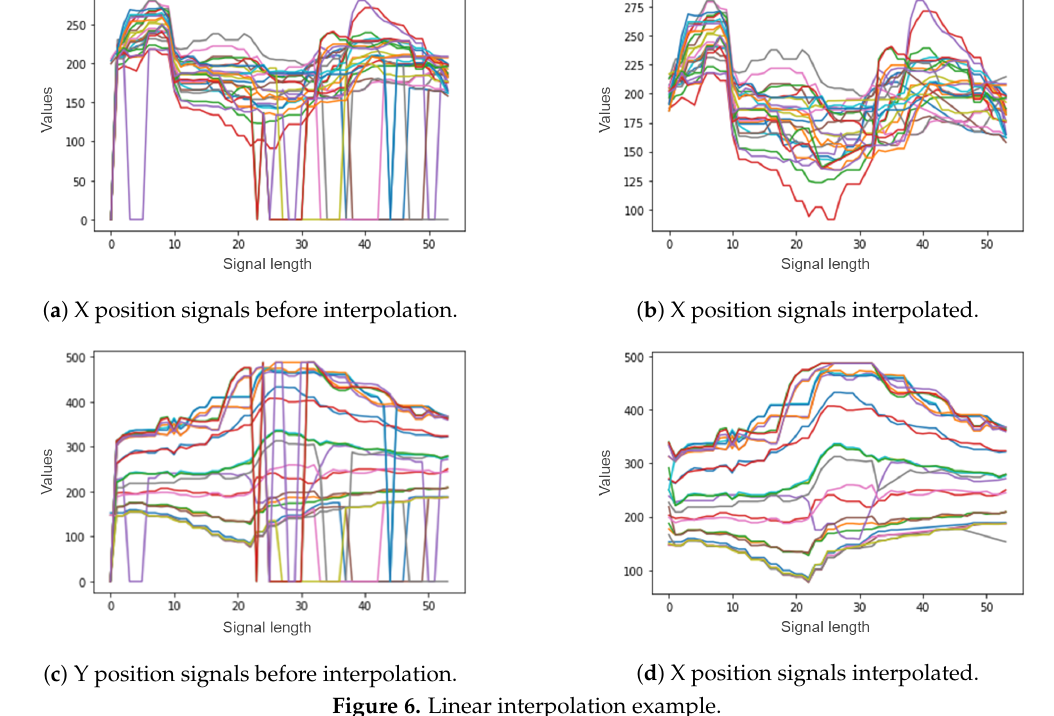
Figure 6. Linear interpolation